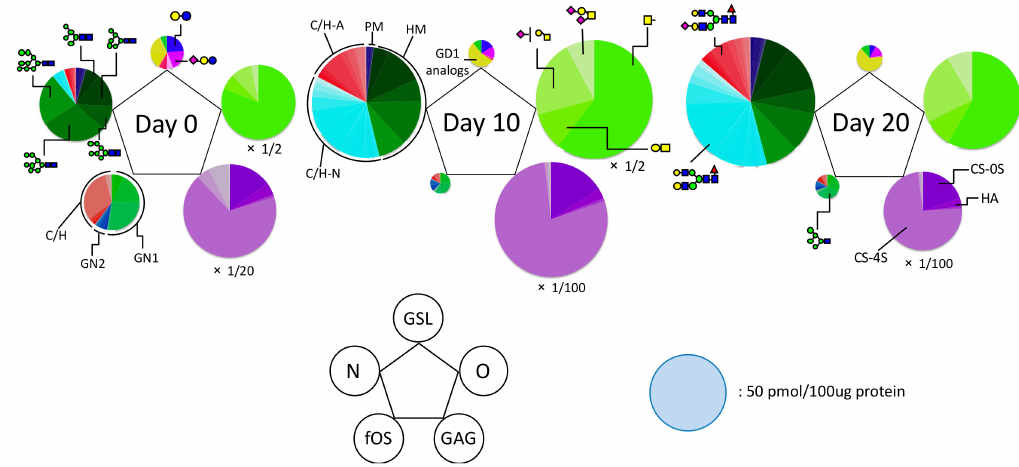
Figure 2. Comprehensive glycomic profiles during hypertrophic di ff erentiation. Pentagonal cellular glycomic notations represent the entire glycome of each time point of hypertrophic di ff erentiation and indicate the relative abundance and diversity of each class of glycoconjugate. Pie charts at the vertices of the pentagon correspond to the glycan expression profiles of N-glycans, free oligosaccharides (fOSs), glycosaminoglycans (GAGs), glycosphingolipid (GSL)-glycans, and O-glycans. The size of each circle and its constituent colors reflect the absolute glycan quantity (50 pmol / 100 µ g of protein) and the glycan substructures, respectively. The sizes of the circles representing the O-glycans and GAGs contents increased by 2-fold and 10-fold (area ratio), respectively. fOS is constituted of neutral oligosaccharides possessing one GlcNAc (GN1) or two GIcNAc (GN2) at the reducing endGN, C / H: complex / hybrid-type fOSs, N-glycans can be structurally classified into pauci-mannose (PM), high-mannose (HM), and complex / hybrid (C / H)-types. Two major components of GAGs are chondroitin sulfate (CS) and hyaluronic acid (HA). The estimated glycan structures are presented as follows: green circle, Man; yellow circle, Gal; blue square, GlcNAc; yellow square, GalNAc; red triangle, Fuc; purple diamond, Neu5Ac; and open diamond, Neu5Gc. The estimated glycan structures are shown in Table